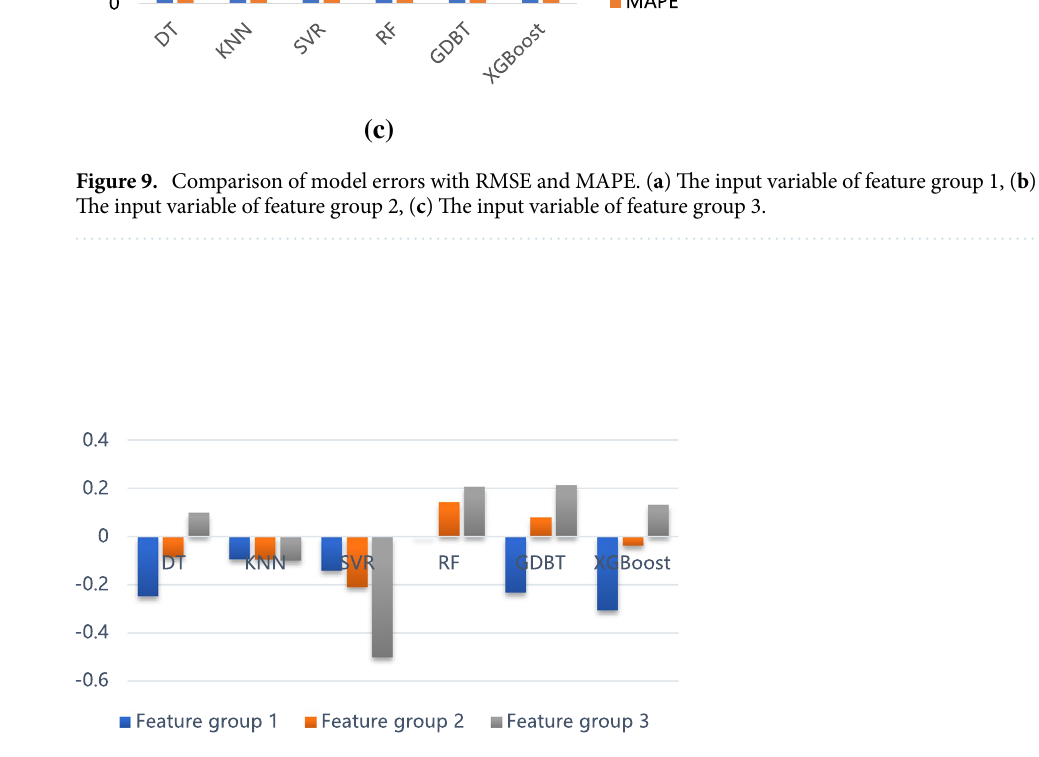
Figure 10. The R 2 of models at different feature